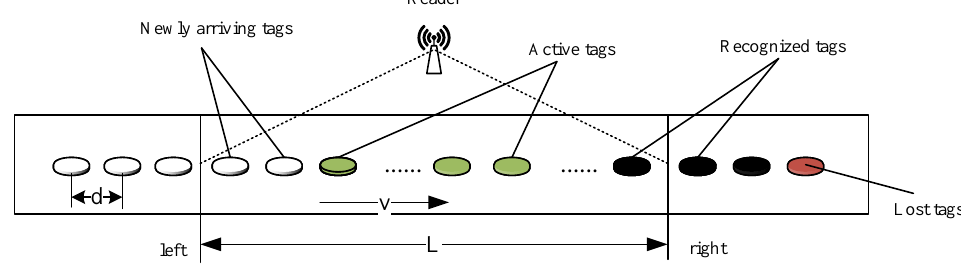
Figure 1. Conveyor-belt-oriented fast-moving RFID system